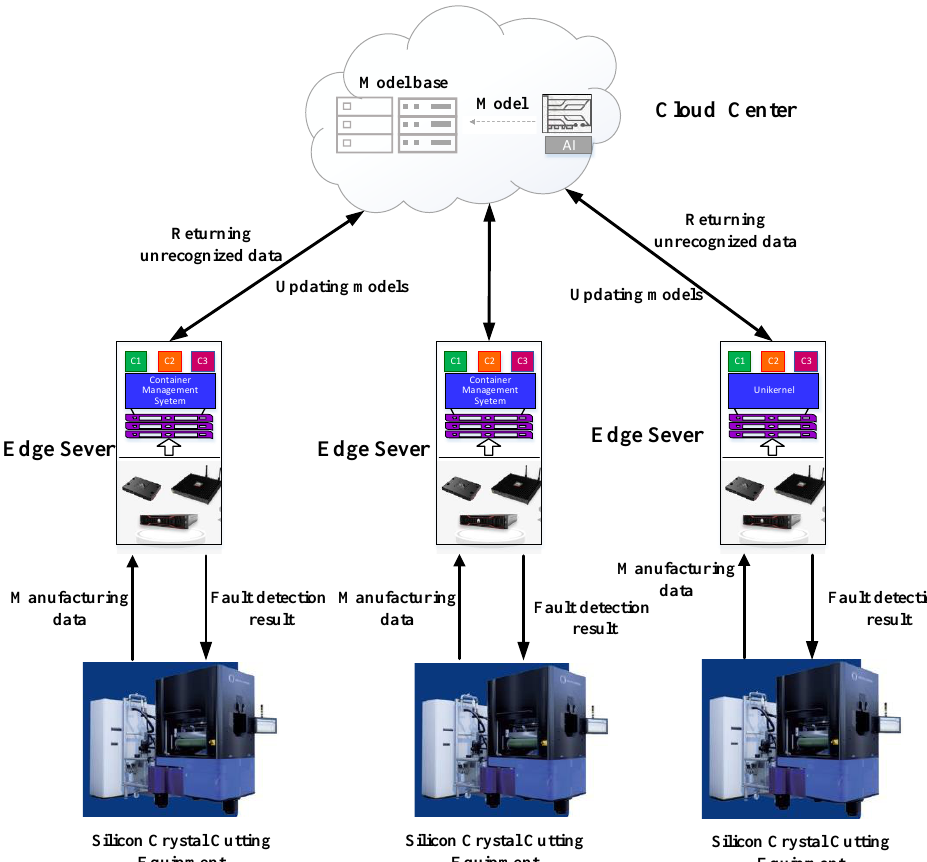
Figure 2. Data-driven and edge-cloud collaboration based a fault diagnosis system.